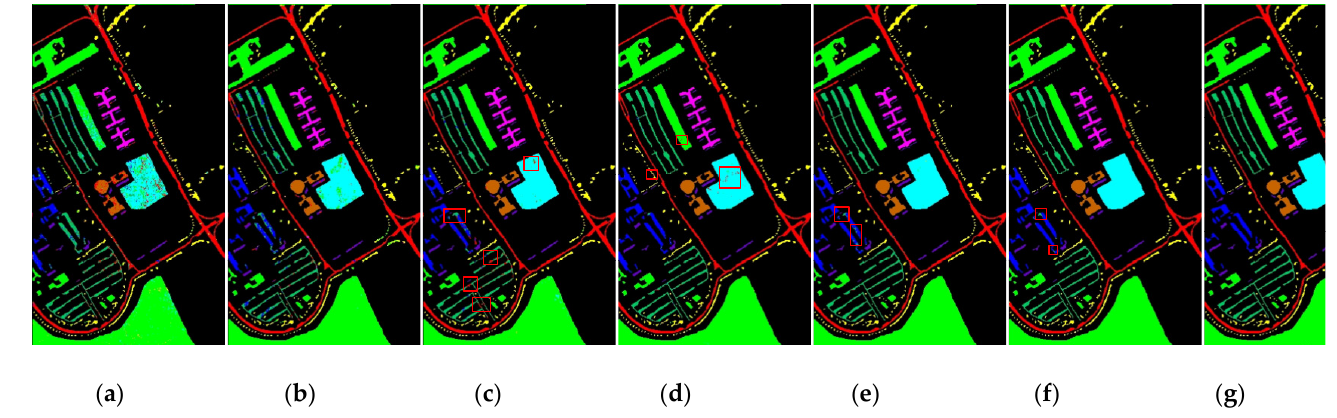
Figure 15. The classification map on the IN dataset for ( a ) SVM, ( b ) 3D-CNN, ( c ) SSAN ( d ) SSRN, ( e ) HSI-BERT, ( f ) SAT, and ( g ) proposed 3DSA-MFN. Red boxes are used to mark non-obvious misclassifications and noise.